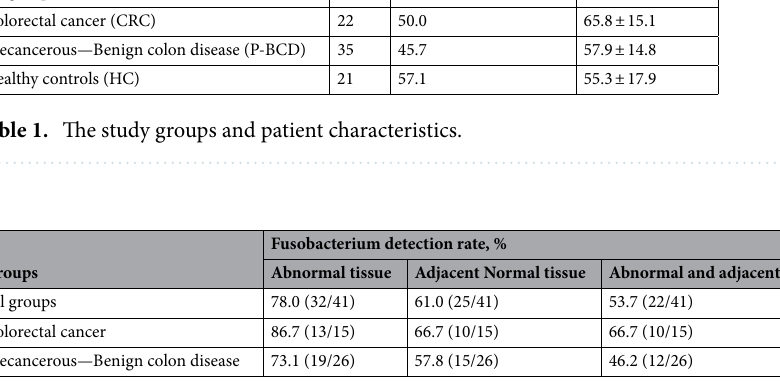
Table 2. F. nucleatum detection rate in tissues using quantitative polymerase chain reaction.